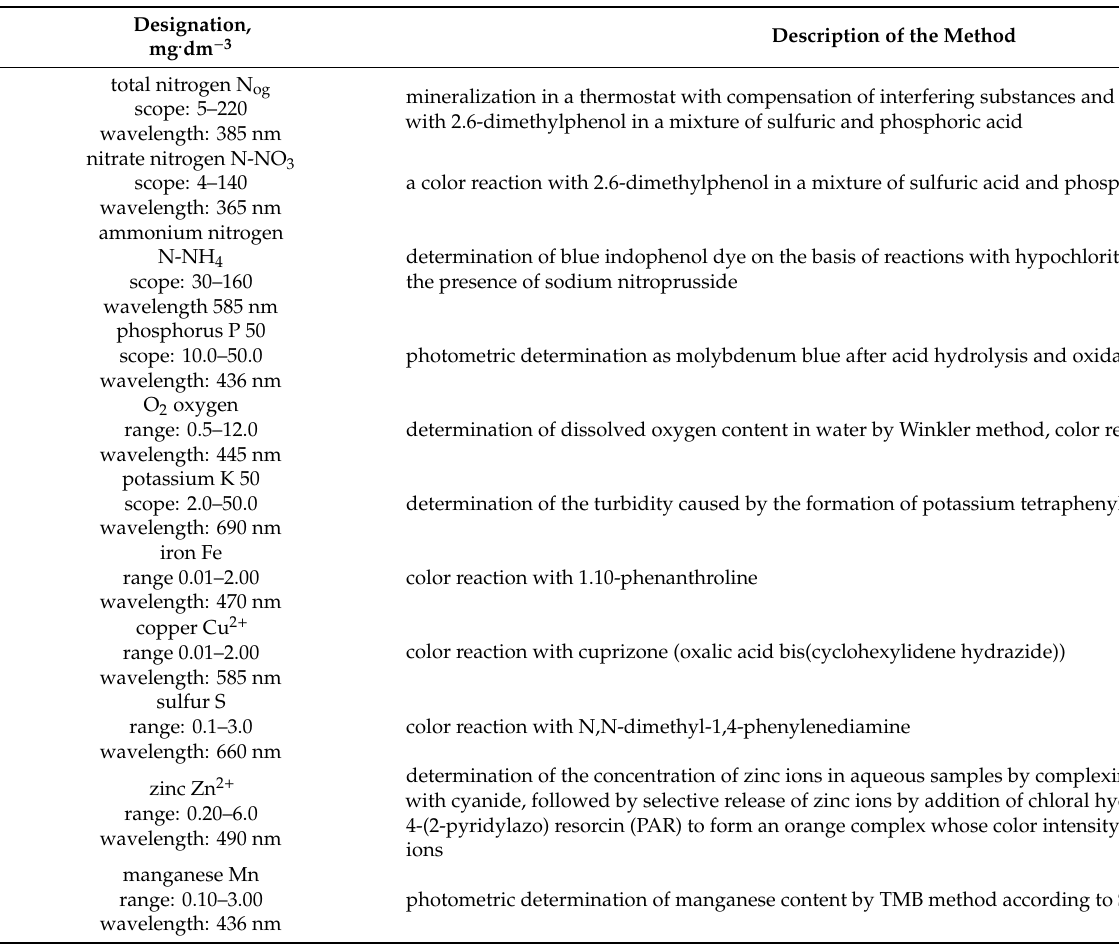
Table 2. List of measurement